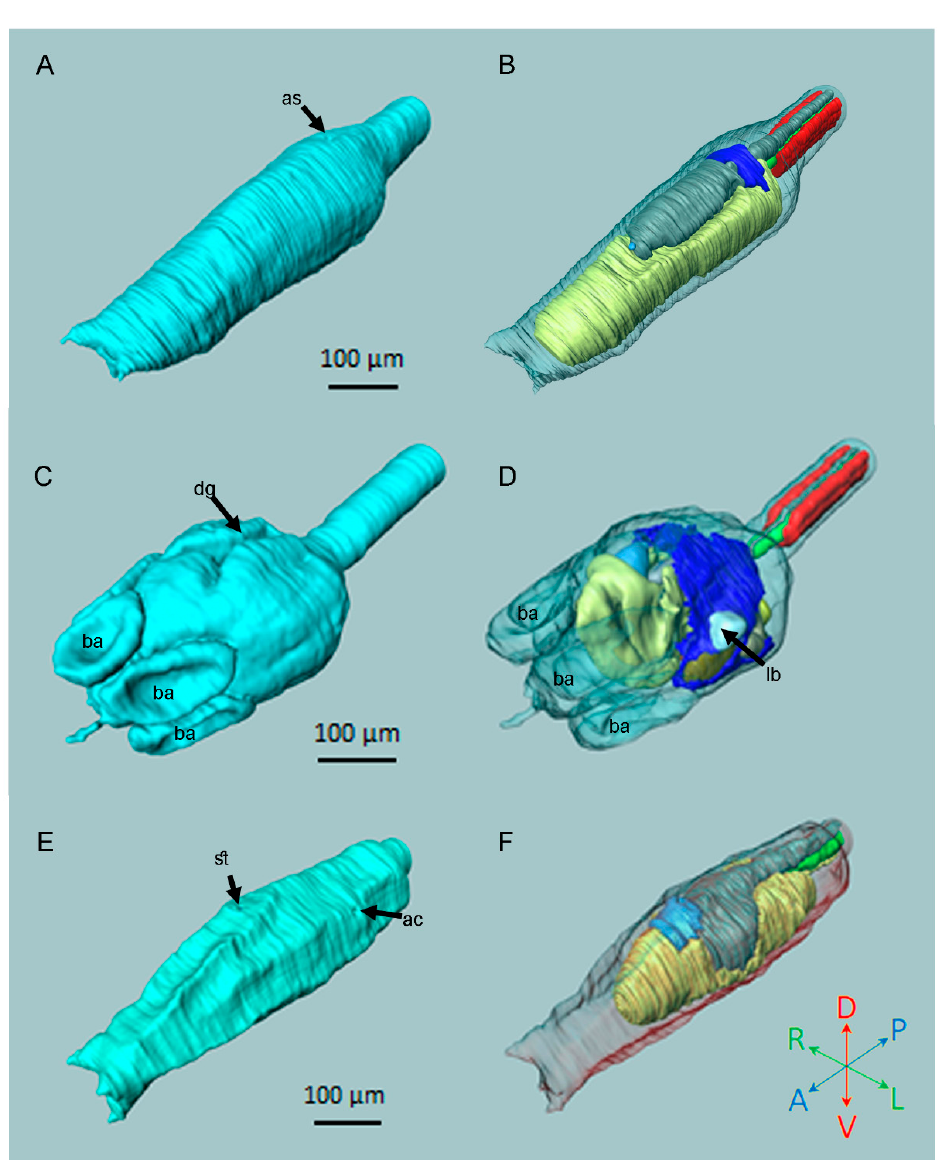
Figure 3. Comparison of the 3D reconstructions of three larvae. ( A , B ) H. roretzi . ( C , D ) B. schlosseri. ( E , F ) C. intestinalis. ( A , C , E ) External views. ( B , D , F ) Internal views (organs are transparent). Colour code as in Figure 1. Note the different levels of adultation. ac, left atrial chamber rudiment; as, atrial siphon rudiment; ba, blood ampulla; dg, dorsal groove; lb, left bud; st, stomodeum. Externally, the trunk of H. roretzi (Figure 3A) is more similar to that of the C. intesti- nalis (Figure 3E) as it is elongated, fusiform, and ends at its anterior-most section with three conic papillae. The two stolidobranch species, H. roretzi and B. schlosseri , share signs of adultation that are absent in C. intestinalis (Figure 3B,D,F; Table 1). In fact, in both stolidobranch species, the atrial chamber forms a well-developed uneven structure; in C. intestinalis , the atrial rudiments are in the form of two dorsal-lateral shallow depressions